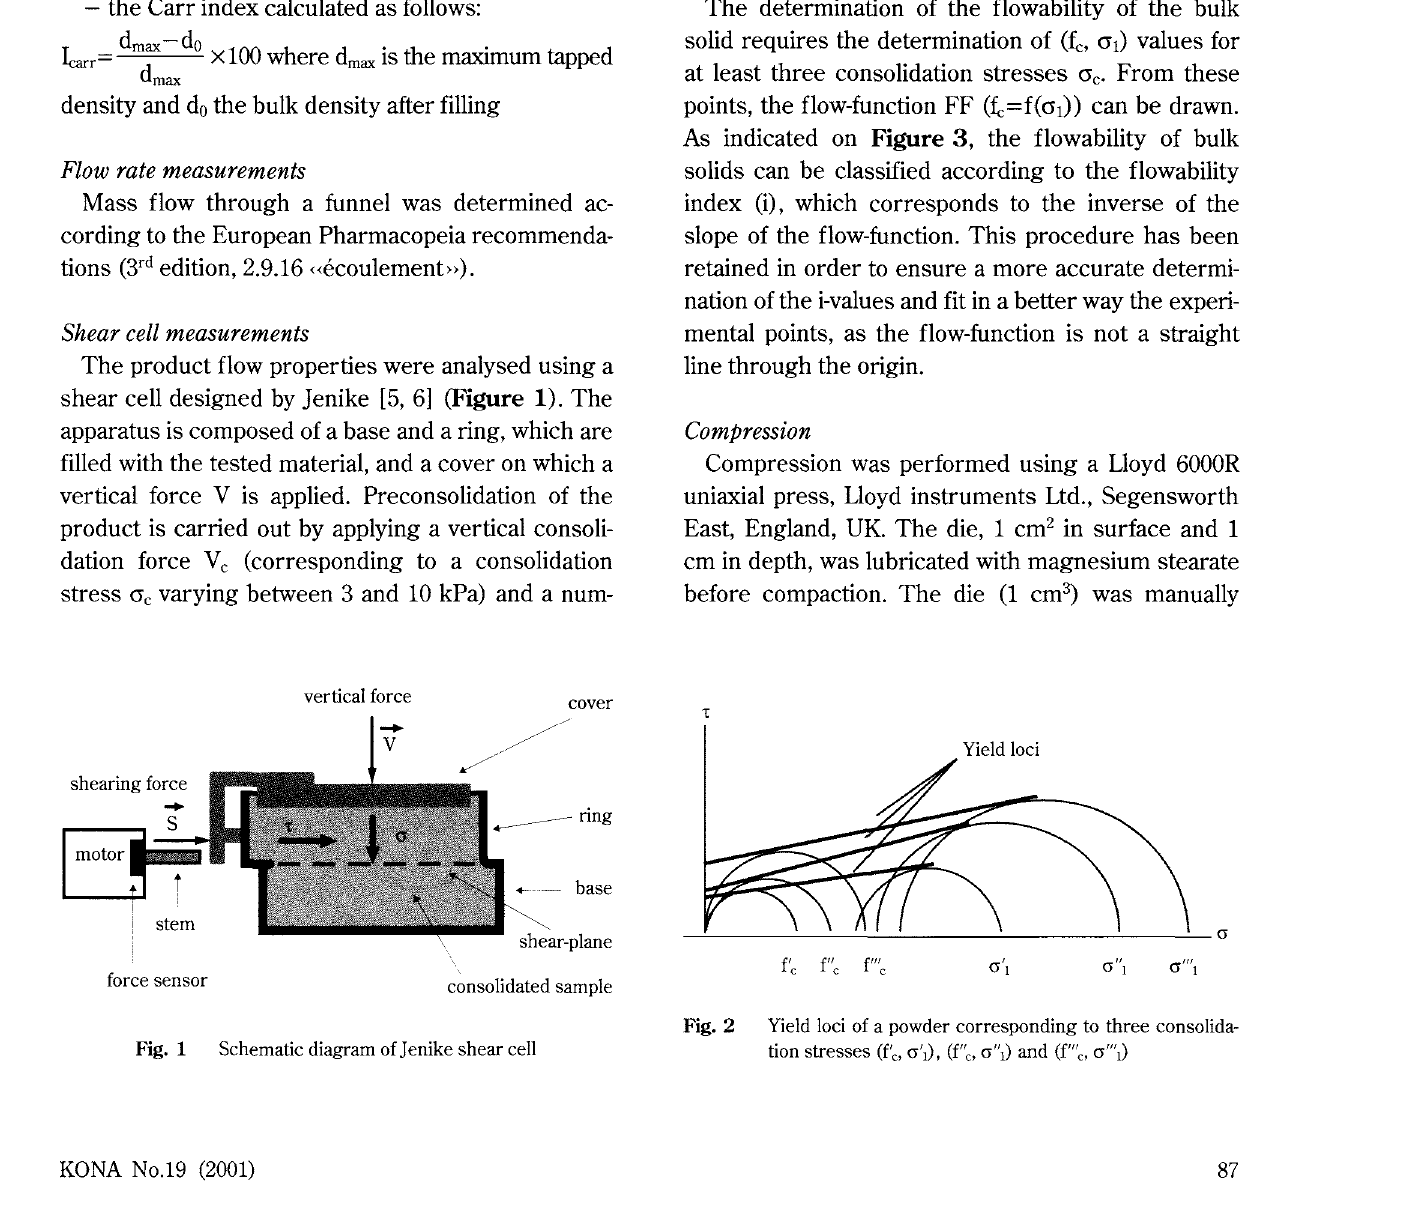
Fig. 1 Schematic diagram of Jenike shear cell